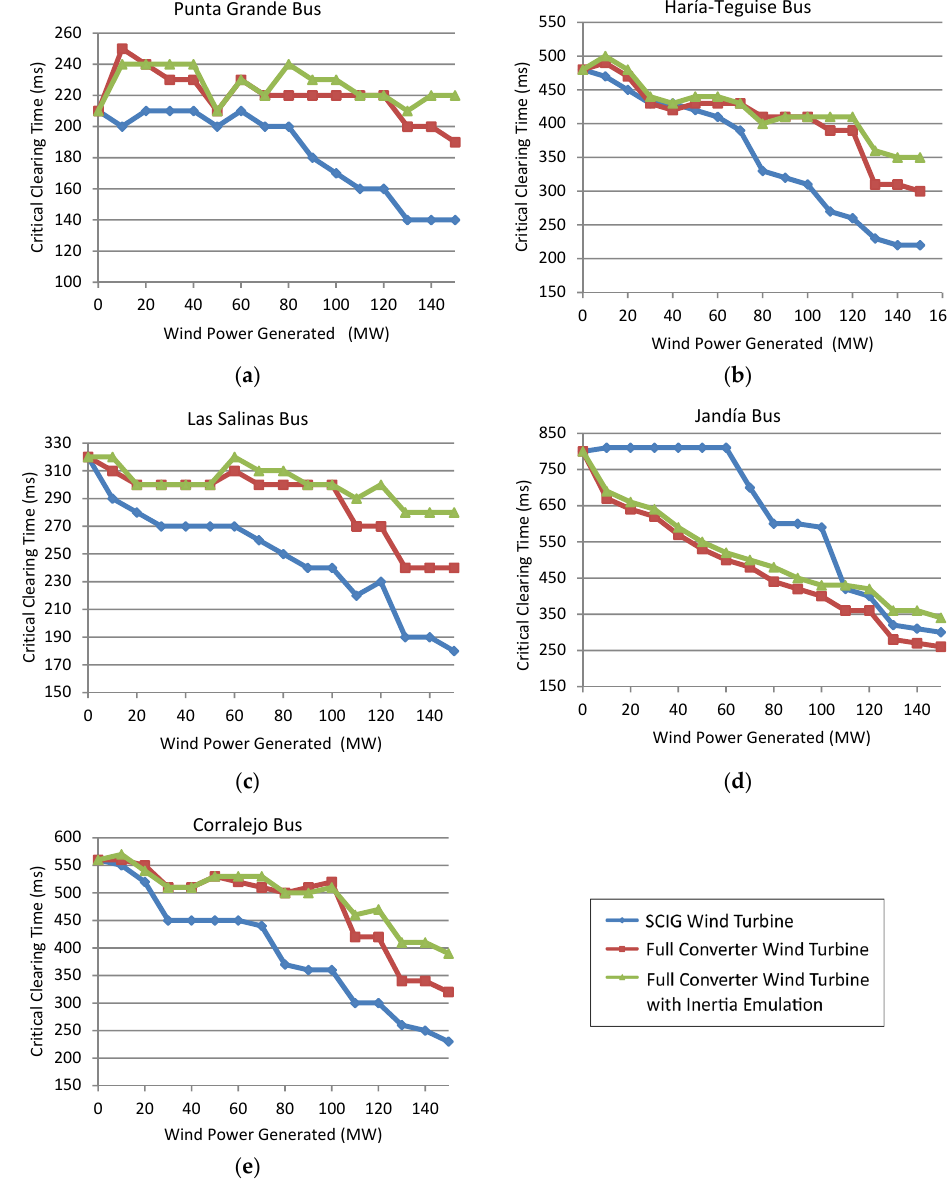
Figure 9. Critical clearing time (CCT) values obtained: ( a ) Punta Grande bus; ( b ) Haría ‐ Teguise bus; ( c ) Las Salinas bus; ( d ) Jandía bus; ( e ) Corralejo bus.